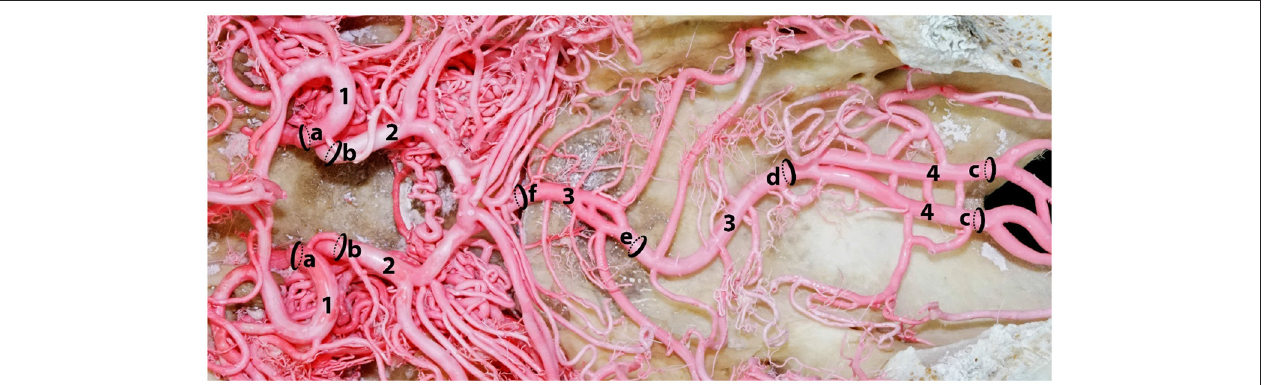
TABLE 1 | Morphometric analysis: Mean Diameter (mm) of various cerebral arteries and testing for variation between the left and right pair. Arterial system Artery Mean diameter (mm) Mean diameter and SD of left Percentage contribution and right pair combined (mm) to the brain (%) Carotid Right rostral cerebral artery 2.7 2.62 ± 0.33** 65.4% Left rostral cerebral artery 2.53 Right caudal communicating artery 2.68 2.63 ± 0.51 Left caudal communicating artery 2.55 Vertebrobasilar Right medullary segment of the basilar artery 2.32 2.38 ± 0.37 34.6% Left medullary segment of the basilar artery 2.45 Right lateral branch of the vertebral artery 1.24 1.26 ± 0.25 Left lateral branch of the vertebral artery